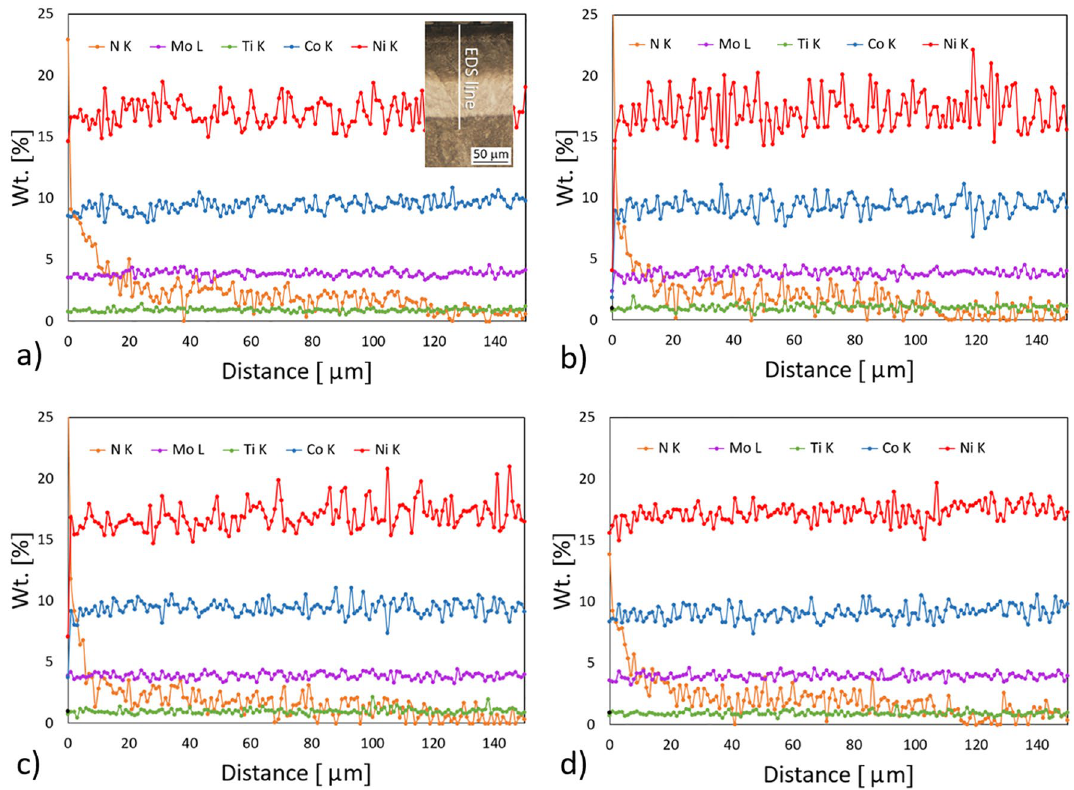
Figure 5. EDS line-scan analyses of: ( a ) AM, ( b ) AM + DAT, ( c ) AM + SAT and ( d ) CM + SAT are shown in Fig. 5. The inset in Fig. 5a schematically shows the EDS line path through the nitride layer, which was similar for all four samples. In all the samples, the nitrogen signal correlates well with the depth of the nitride layer, which is 115–130 µm, as seen from the LM micrographs. The content of nitrogen starts to increase in the top 20 µm, which corresponds well with the compound layer visible in the SEM images (Fig. 3) and the hardness